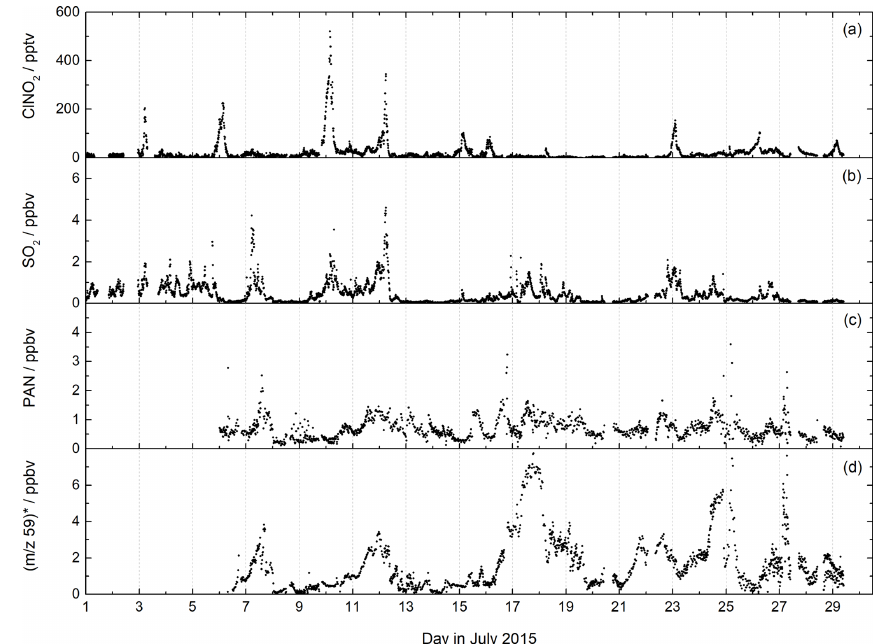
Figure 7. CI-QMS time series of ClNO 2 , SO 2 , PAN mixing ratios and m/z 59 during the NOTOMO field campaign in Germany. The signal at m/z 59 was converted to ppbv, assuming that it consists only of acetic acid (no peracetic acid). The mixing ratios are therefore only an upper limit. For comparison with the PARADE campaign at the same location see Fig. S7.